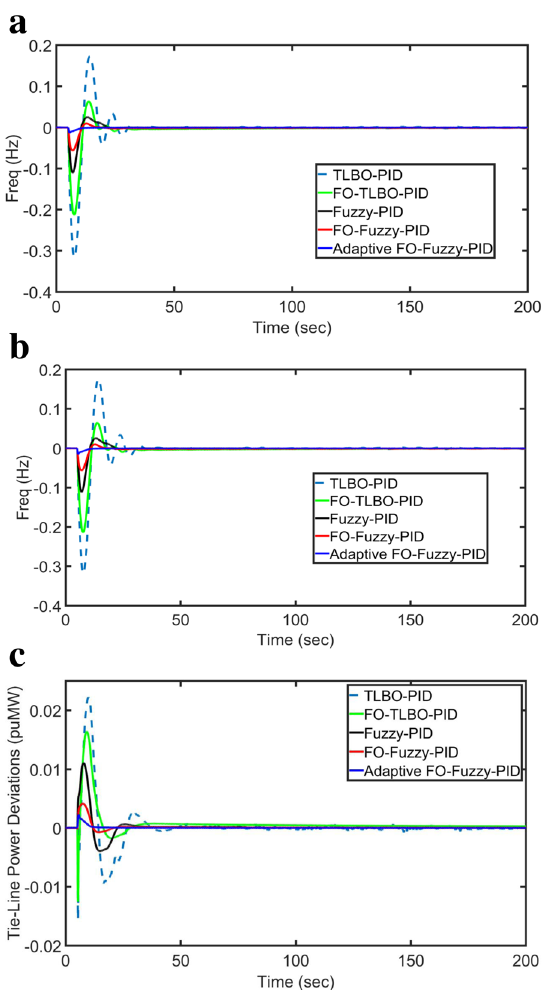
Fig. 10 Frequency deviation response of a area 1, b area 2 for scenario 2, c Tie-line power deviation